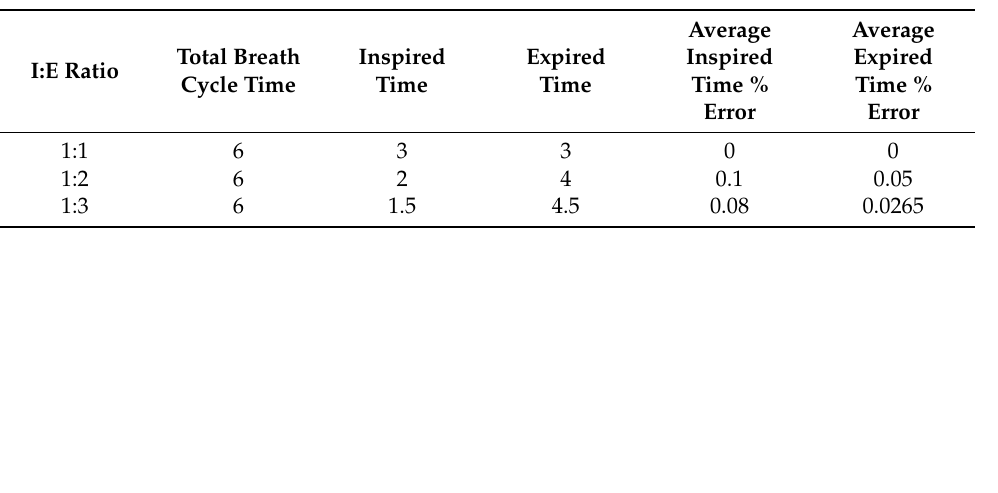
Table 3. Inspired-time and expired-time test results for BPM of